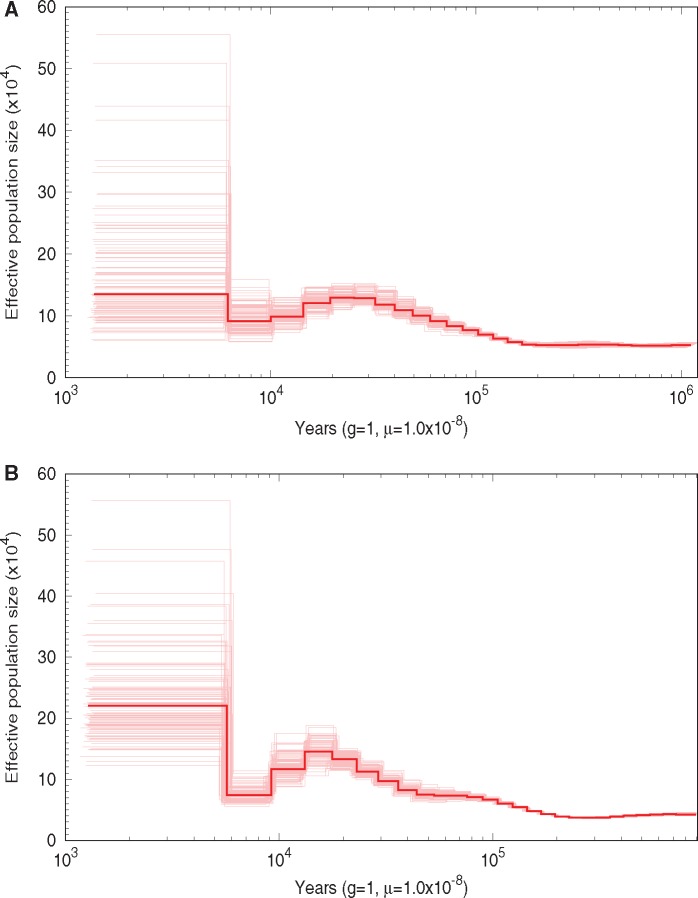
—Lake Washington and Puget Sound have experienced past population bottlenecks. Demographic history for Lake Washington (A) and Puget Sound (B) was estimated using PSMC from a single female fish from each population. One hundred bootstrap replicates around the estimated history are shown.